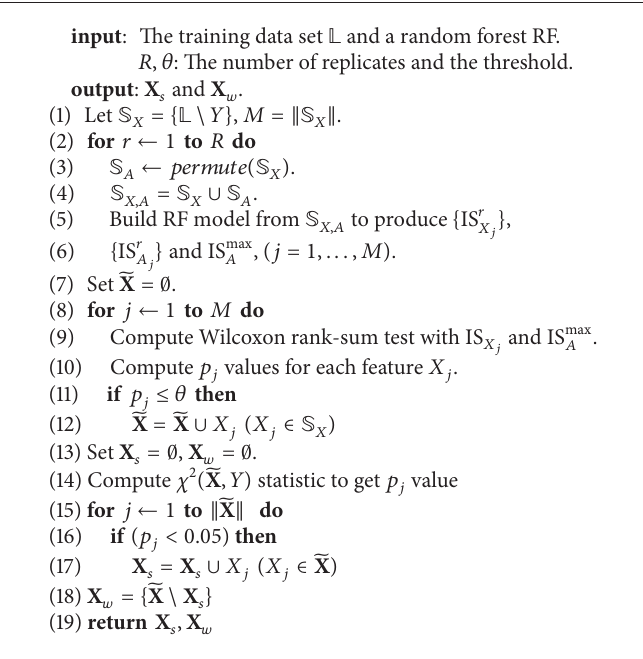
Algorithm 2: Feature subspace selection.